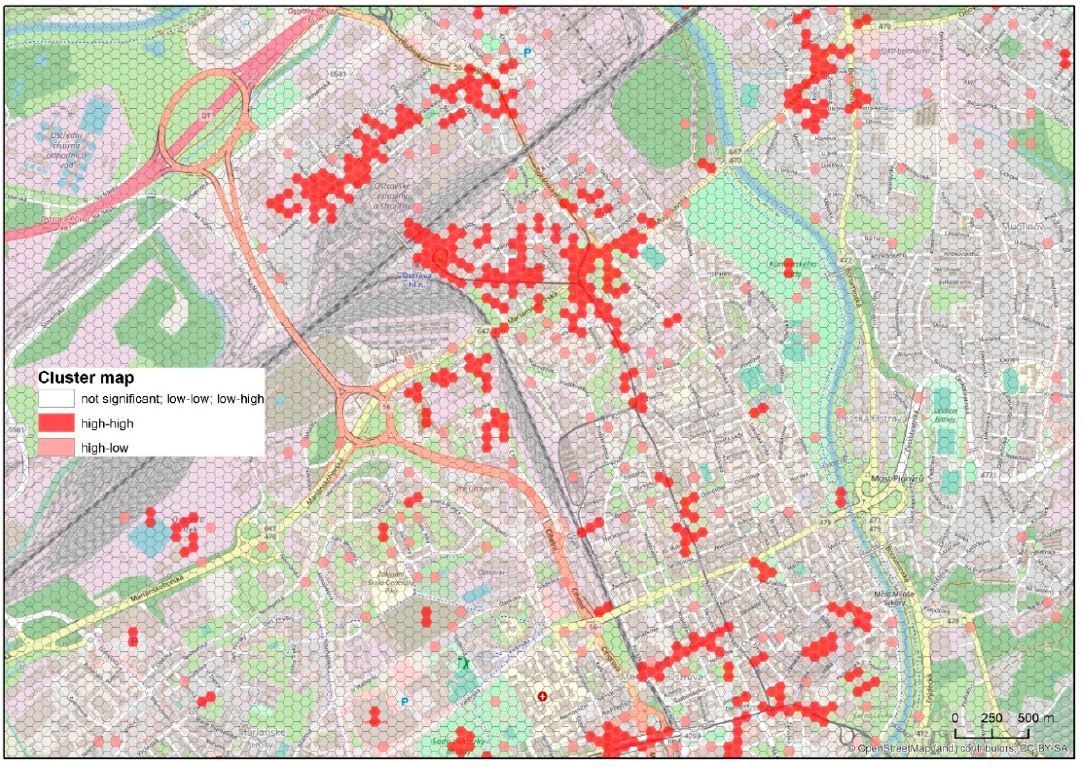
Figure 3. Cluster map of fear of crime events (all events).